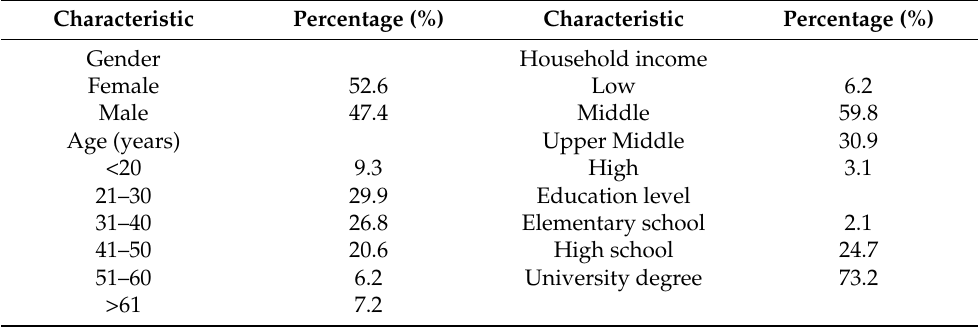
Table 2. The socio-demographic characteristics of the respondents in sensory